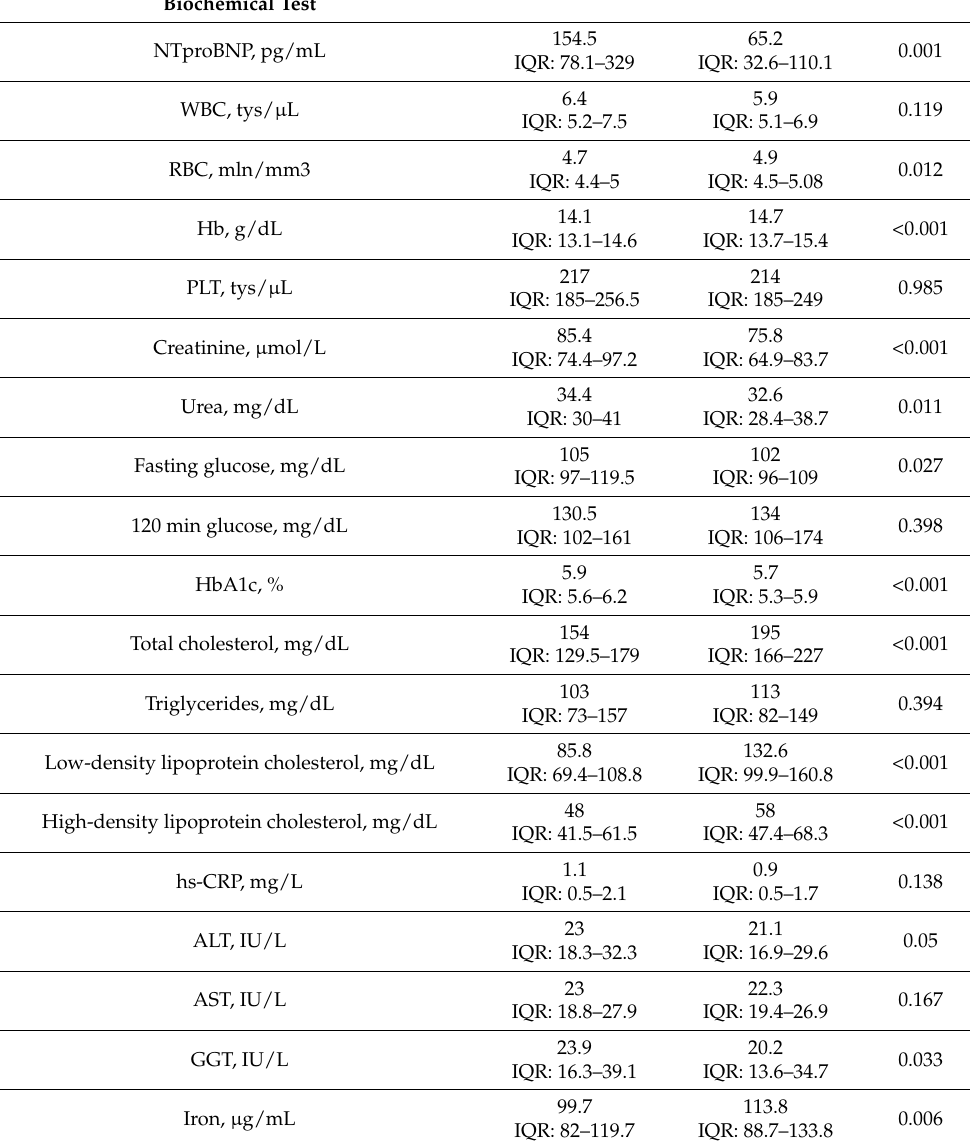
Table 3. Biochemical